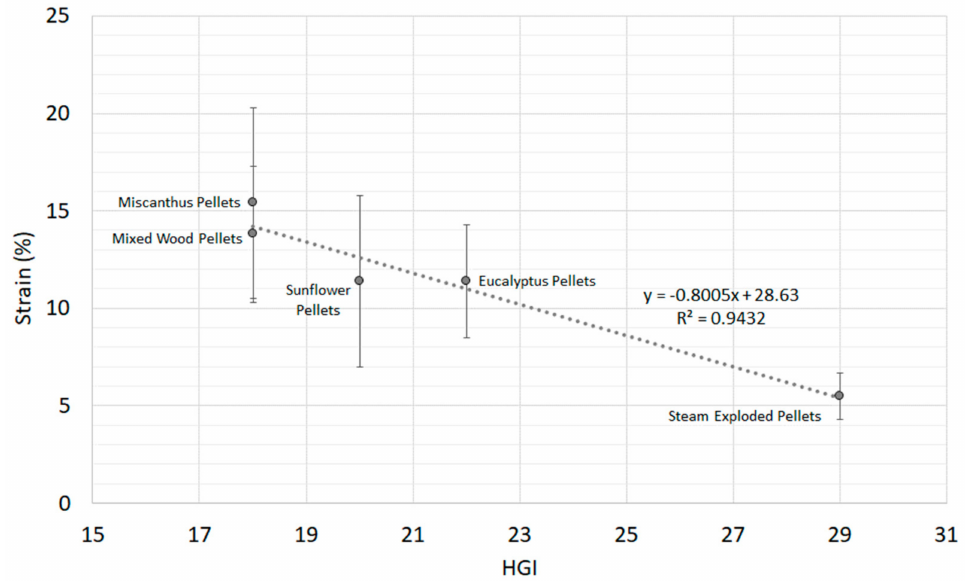
Figure 6. Biomass pellet diametral ductility versus HGI (HGI n = 2, ductility n =